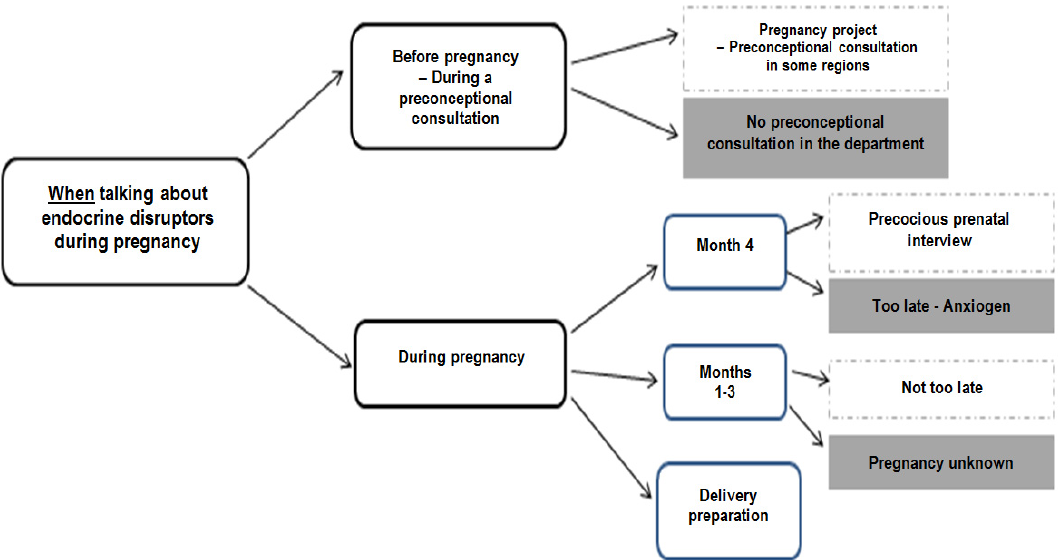
Figure 2. Perception of professionals on “when talking about endocrine disruptors during pregnancy”.